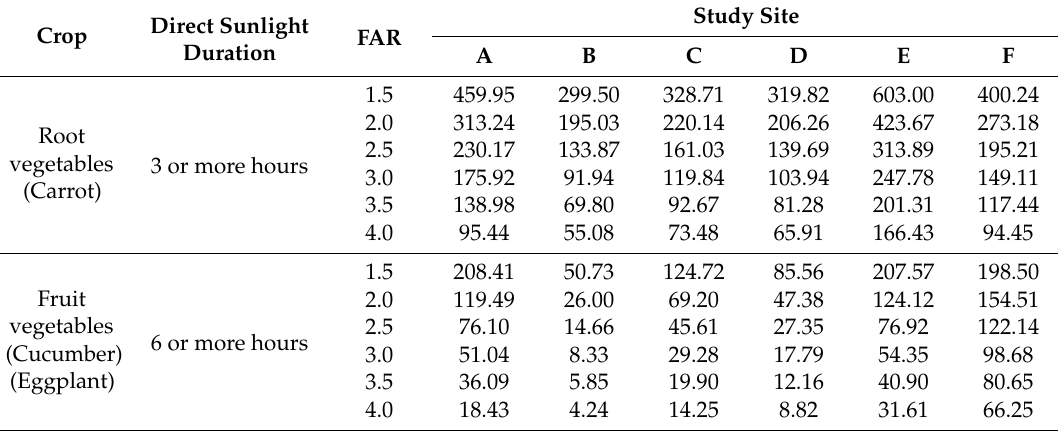
Table 4. Estimation of crop yields (grams per housing unit) for each study site at the six density